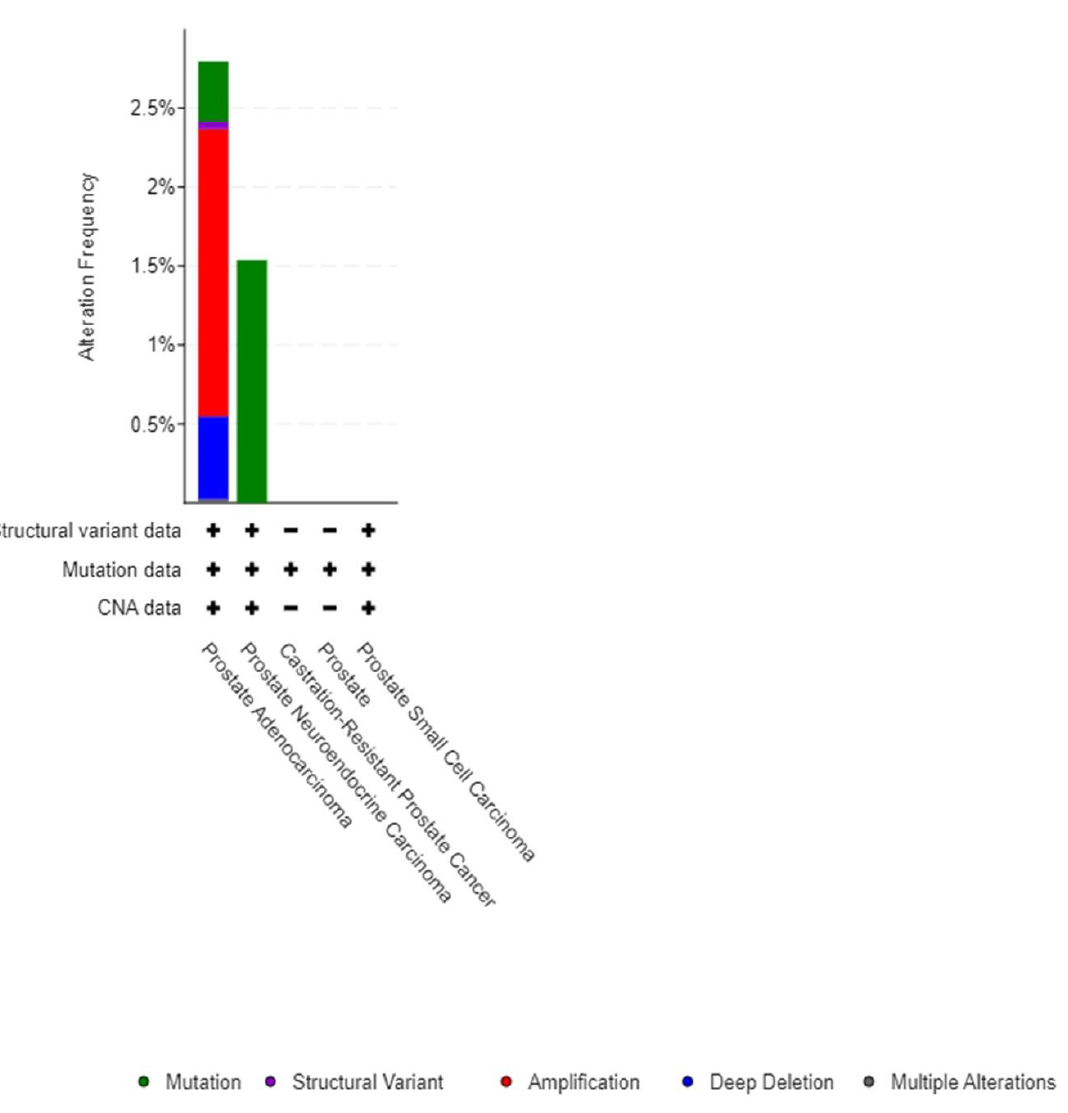
Figure 4. Cancer type summary.